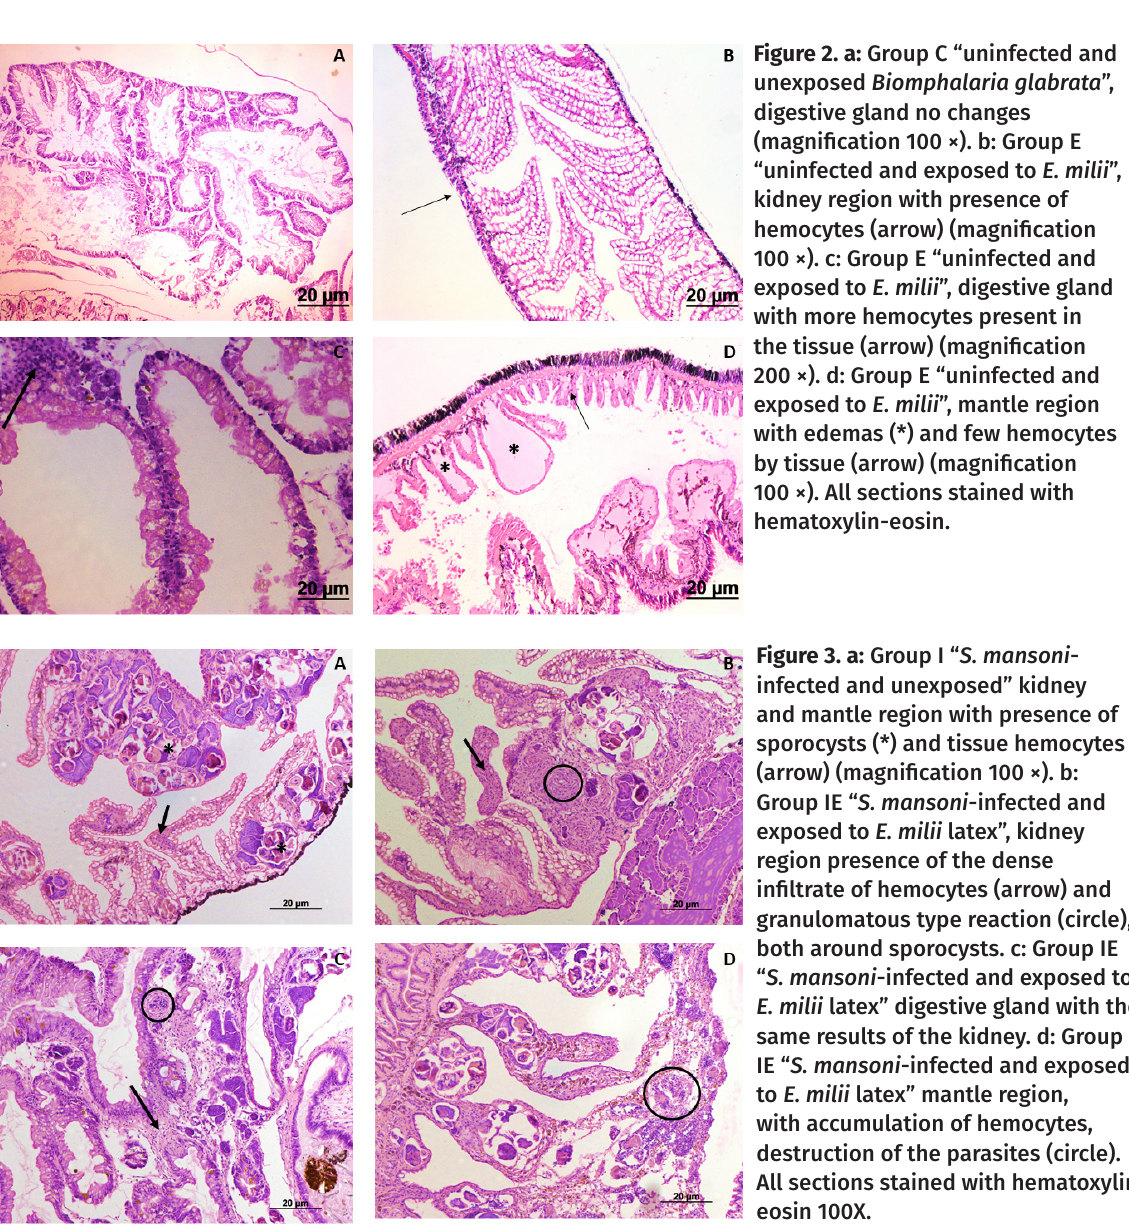
Tetrapleura tetraptera extract on some fresh water snails. Fitoterapia 5: 571-574. ALLIENNE JF, THÉRON A & GOURBAL B . 2011. Recovery of primary sporocysts in vivo in the Schistosoma mansoni / Biomphalaria glabrata model using a simple fixation method suitable for extraction of genomic DNA and RNA. Exp Parasitol 129: 11-16.